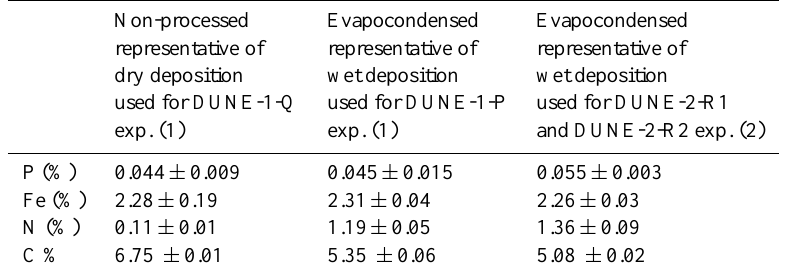
Table 2. Composition of some key elements in the dust used for seedings during DUNE.